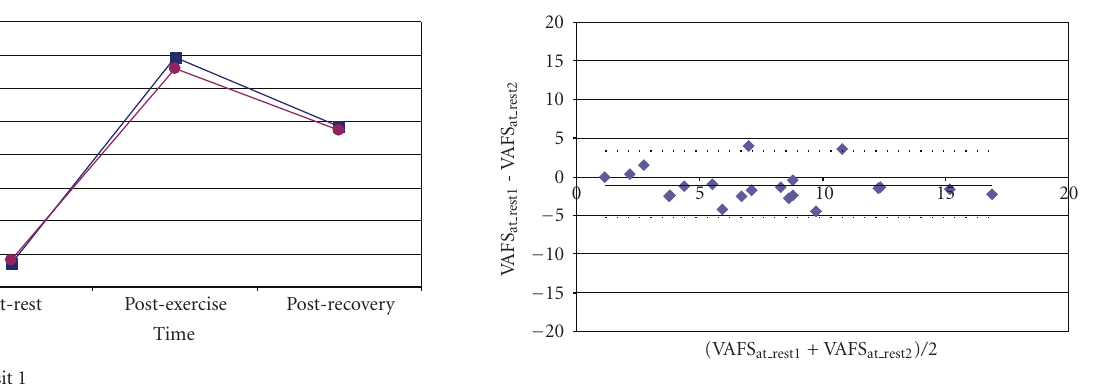
Figure 3: Bland-Altman plot of the VAFS scores at rest from Visits 1 and 2 indicates no shift and low variability. VAFS: Visual Analog Fatigue